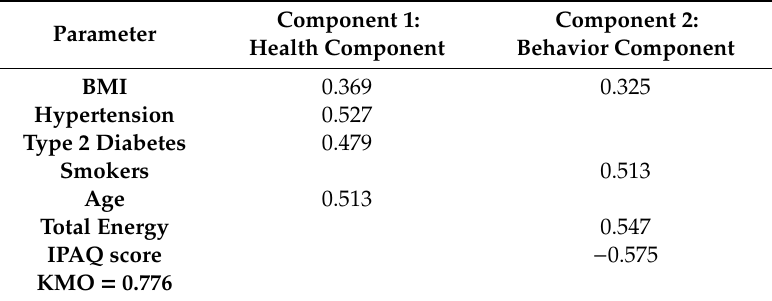
Table 1. Principal Components variable loading from Polychoric analysis. Parameter